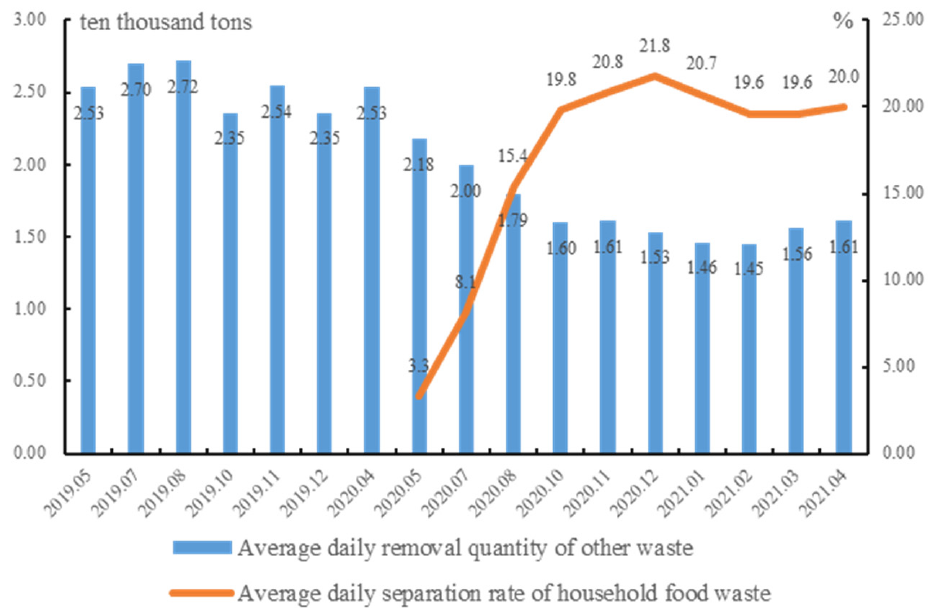
Figure 1. Average daily household food waste separation rate and other waste removal quantity in Beijing. Data source: Press conferences on the implementation of the 2020 Beijing Decree on Domestic Waste Management.